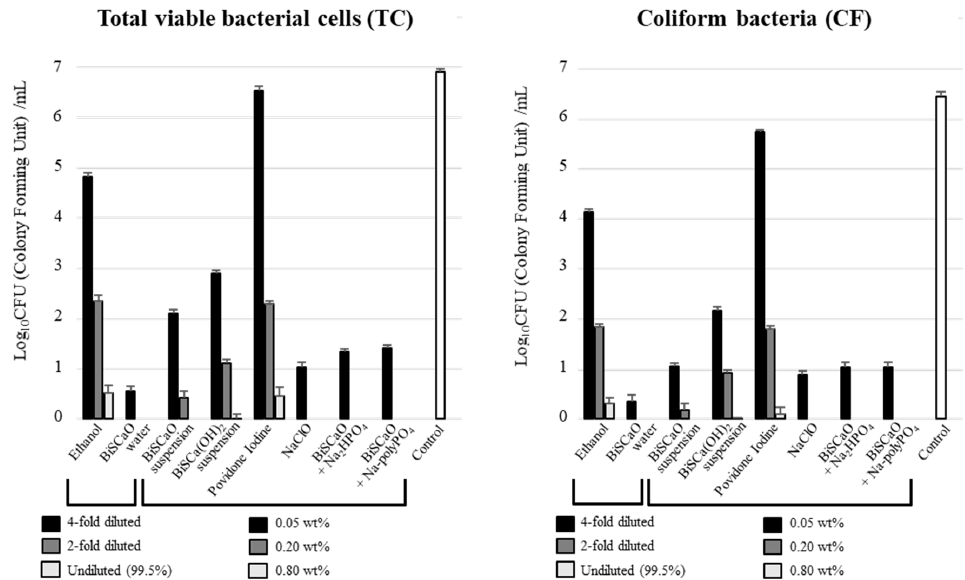
Figure 4. Disinfection efficacy using wood pieces. TC (left) and CF (right) released from the contaminated wood piece in each sample were measured as CFU/mL. BiSCaO Water, dispersion, and colloidal dispersion had high microbicidal activity. Plating and counting were performed as a set of 4 technical replicates (n = 4).